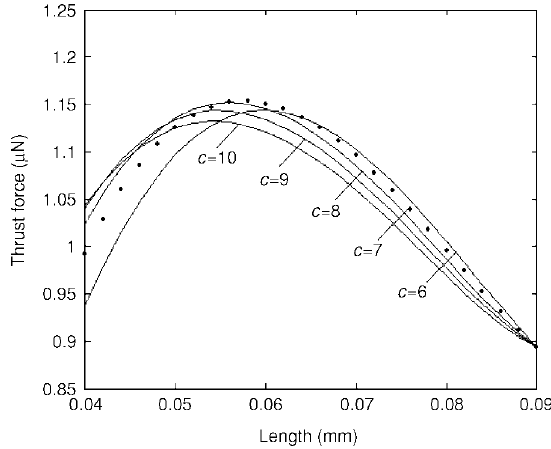
Figure 10 Propulsion diagram when b = 0.02 and c ∈ [6 ,